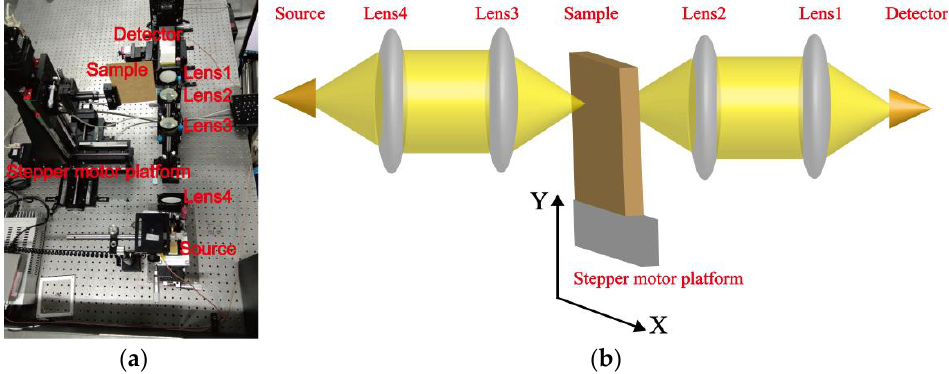
Figure 6. ( a ) Photograph and ( b ) schematic diagram of the THz raster-scan imaging system.